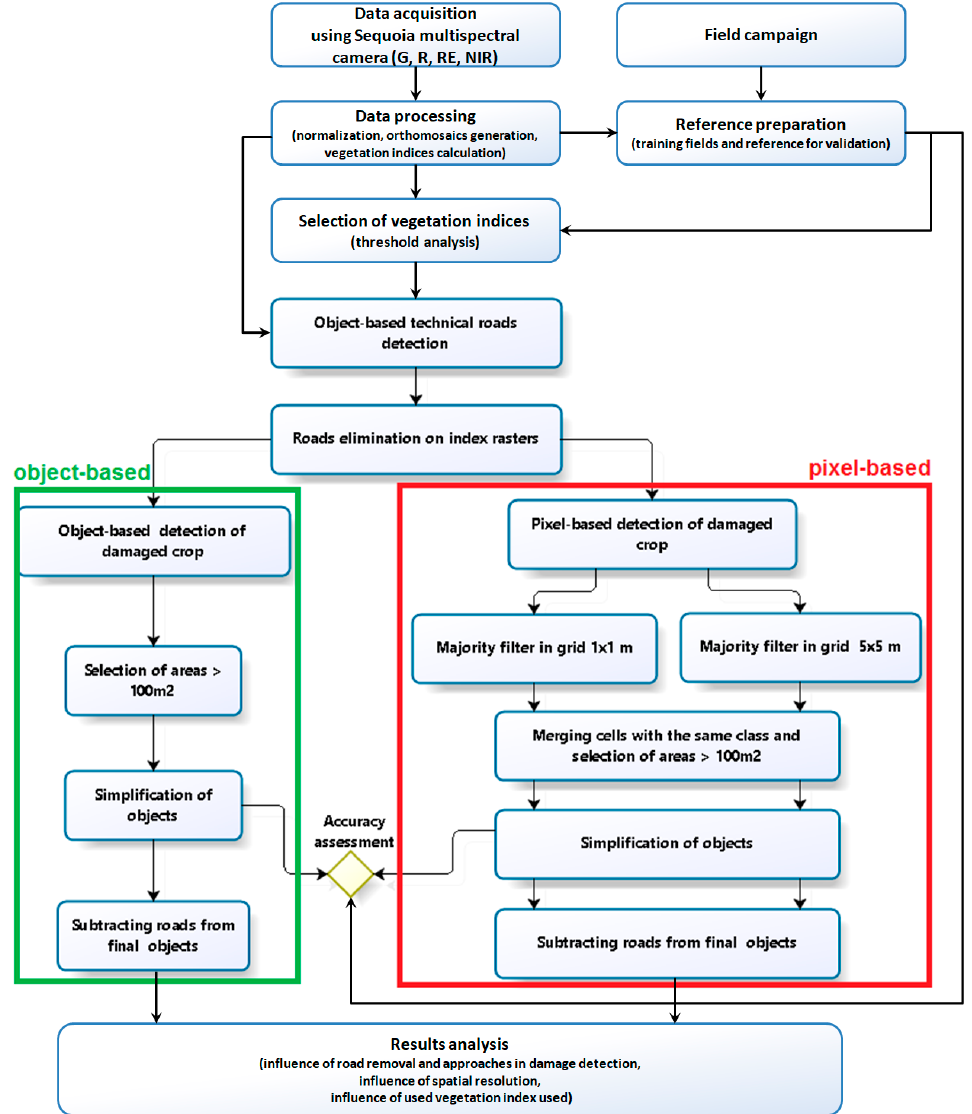
Figure 1. The scheme of the experiment performed.